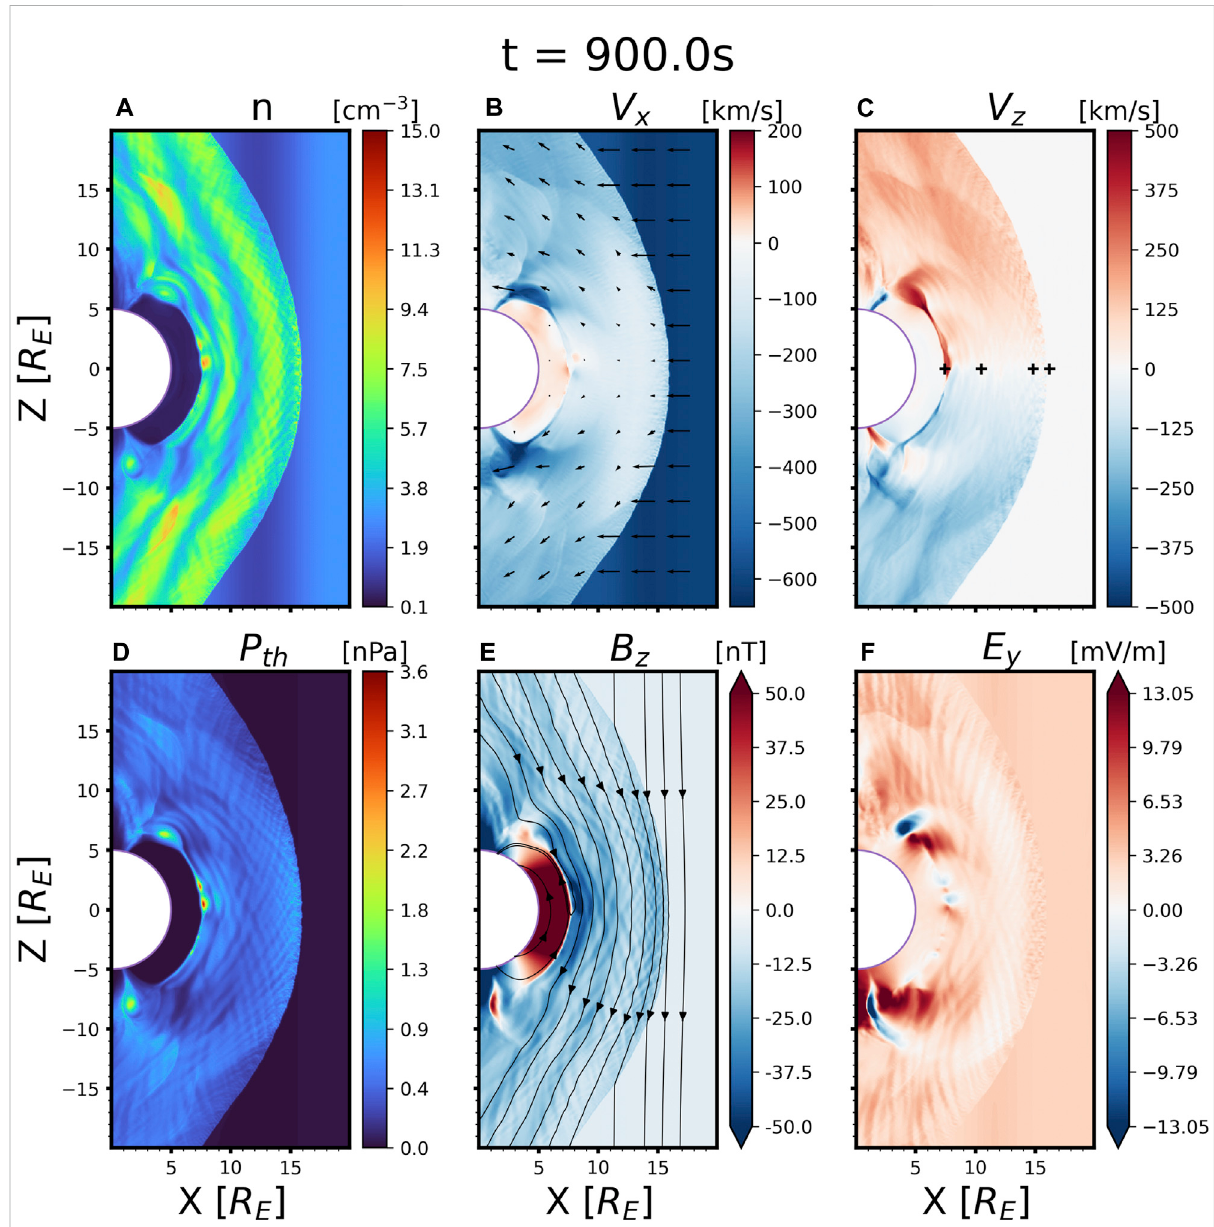
FIGURE 2 Selected plasma moments and EM fi eld components from x ∈ [0, 20] R E , z ∈ [ − 20, 20] R E . All quantities are shown in linear scales. Continuous colormaps are applied to non-negative quantities, and divergent colormaps are applied to vector components, with zeros shown as white. Two separate linear color scales are used for positive and negative values of V x . The arrows in the colorbars represent saturated colors with magnitudes thatareequalorlargerthanthechosenvalues.Quiversofin-planebulkvelocitycomponentsareoverplottedin (B) ,andin-planemagnetic fi eld line projections are overplotted in (E) . Four plus signs in (C) mark the virtual satellite locations in Figure